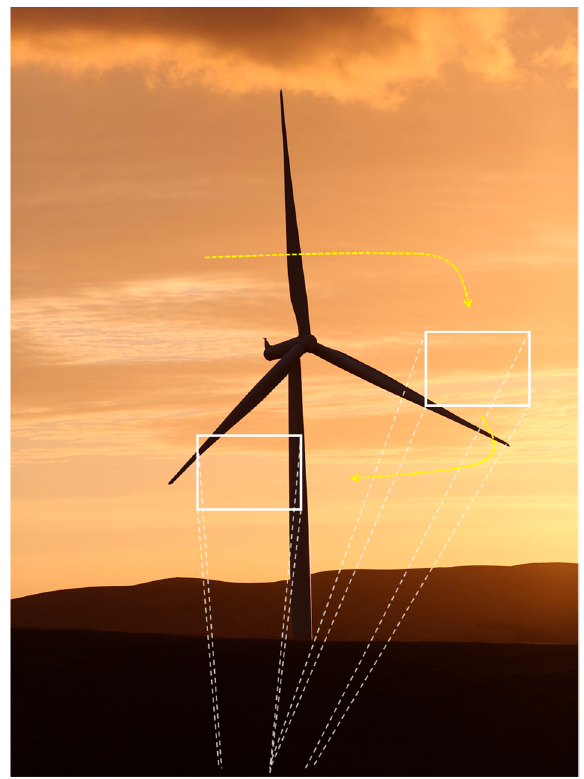
Figure 2. Example thermal-imaging camera frame views (white squares) from nocturnal survey station as views shifted while slowly swiveling camera mounted on tripod. During actual surveys, the sky was completely dark.